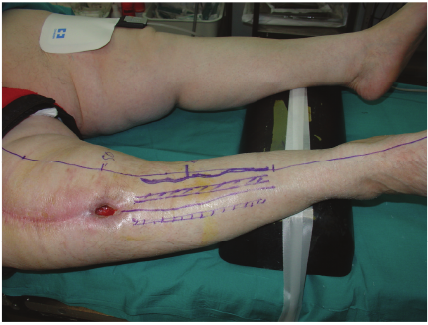
Figure 1: Knee wound secondary to a lymphocutaneous fistula.